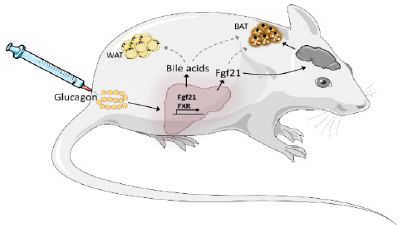
Figure 2. Proposed model of how chronic glucagon treatment increases energy expenditure in mice. Chronic glucagon treatment increases the synthesis and secretion of hepatic Fgf21. Fgf21, in turn, augments the sympathetic output and innervation of BAT via actions on the brain, increasing energy expenditure. Whether chronic glucagon has direct metabolic e ff ects on WAT and BAT is uncertain. In addition, chronic glucagon treatment increases circulating bile acids, which are known modulators of whole body energy metabolism. To which extent bile acids mediate the chronic e ff ects of chronic glucagon treatment is under current